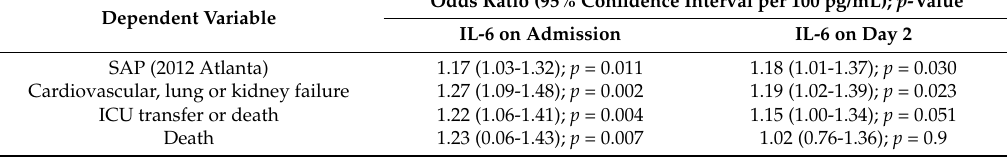
Table 4. Simple logistic regression models to predict severe course of AP based on serum IL-6